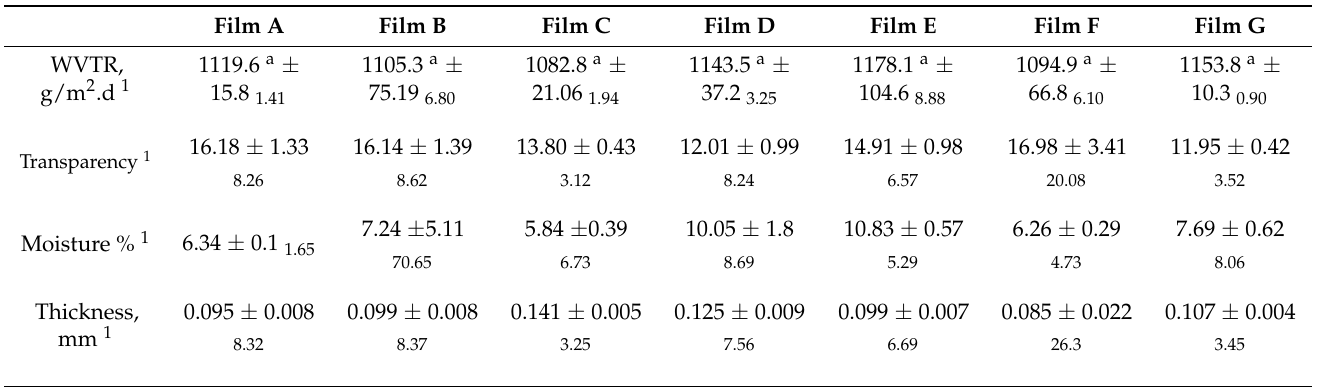
Table 4. Water vapour transmission rate, transparency, water content and thickness of the heat pressed films.